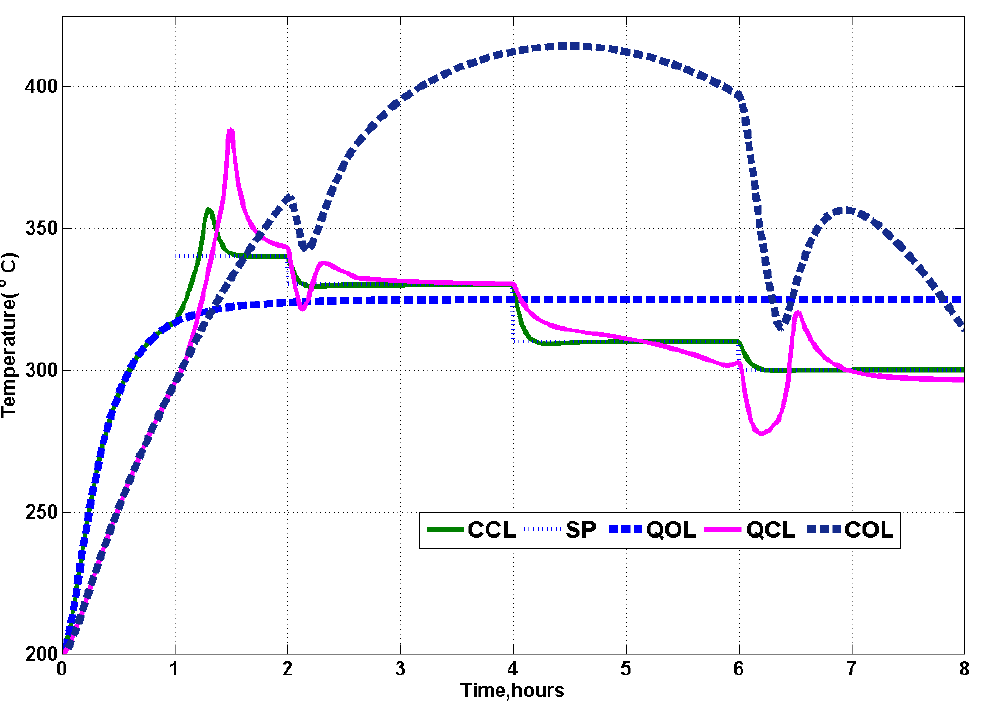
Figure 11. Process variables (PV) of molten salt.